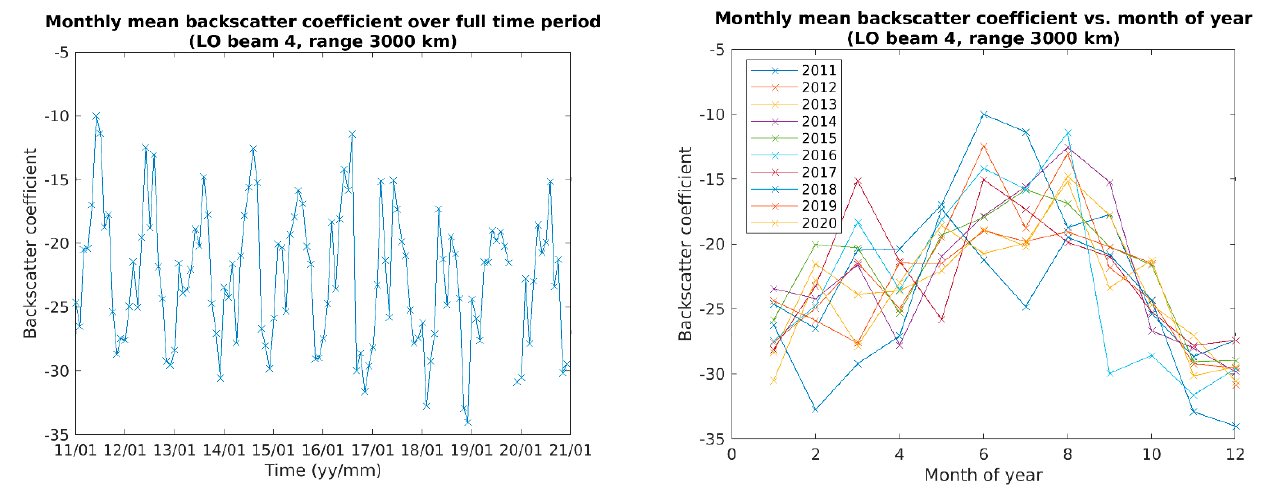
Figure 9. Monthly mean backscatter coefficient over time for LO beam 4, range 3000 km. ( Left ): plotted for the decade from 2011 to 2020. ( Right ): Plotted against the month of year.